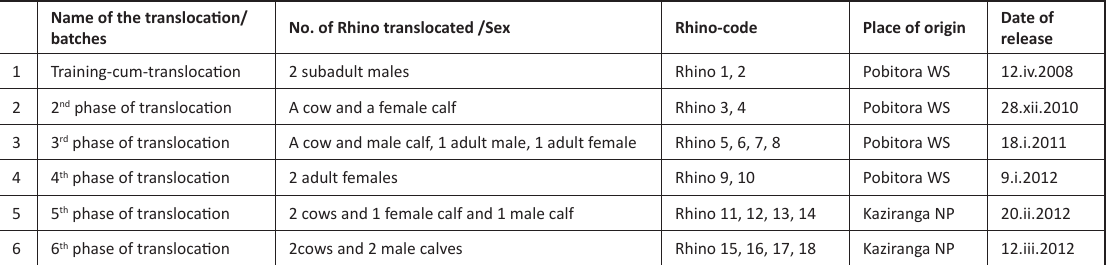
Table 2. Details of rhino translocation to Manas National Park